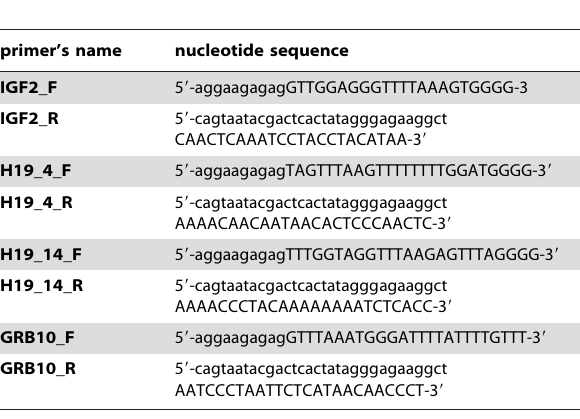
Table 3. Primers used in the Sequenom study to amplify IGF2 , ICR1/H19 and GRB10 regions.